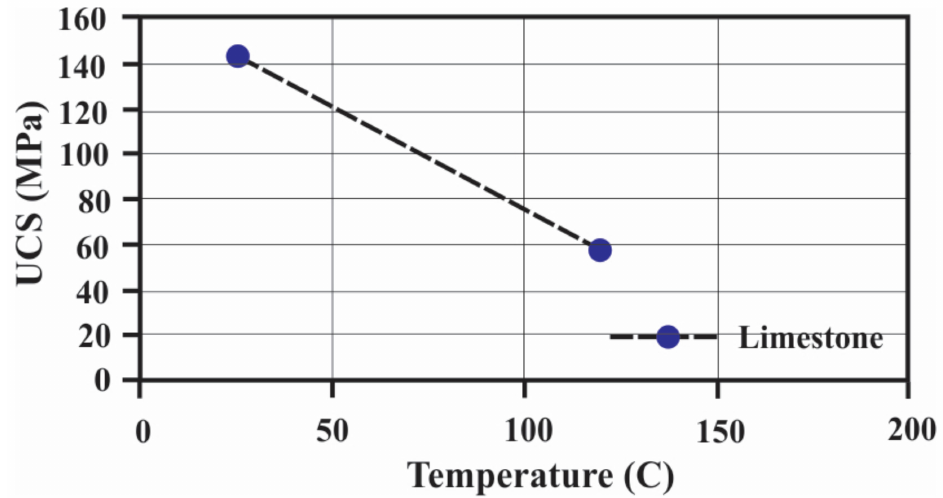
Figure 3. The effect of temperature on uniaxial compressive strength (UCS) in carbonate sedimentary rocks (modified after Pini´nska,